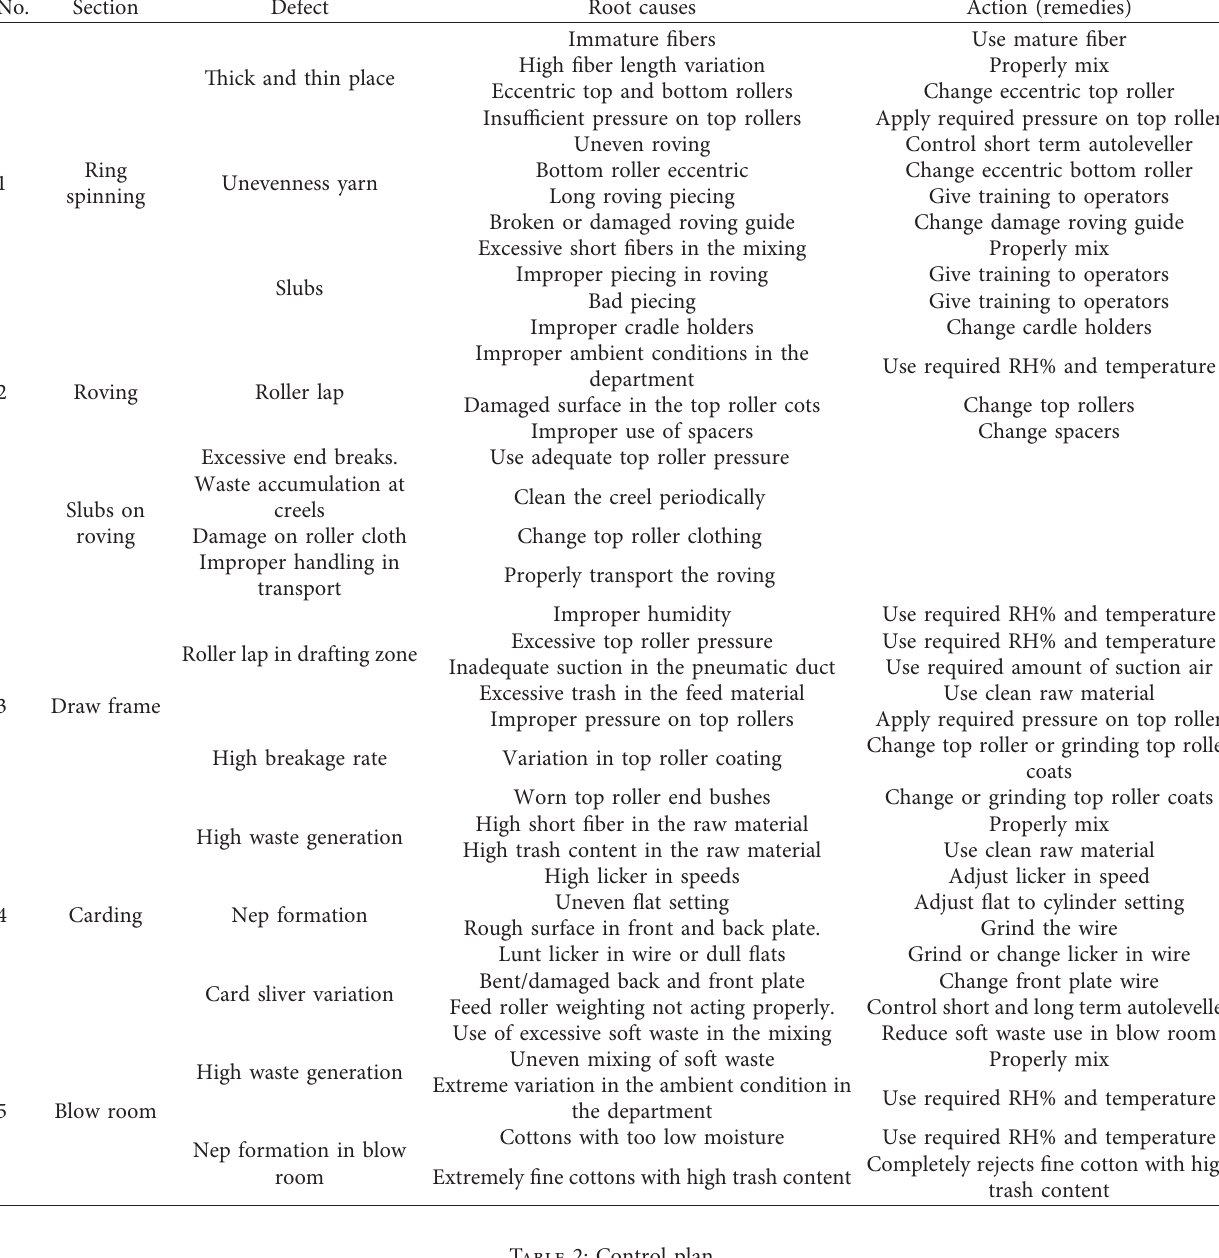
Table 1: Root causes and their remedies in carded yarn process.